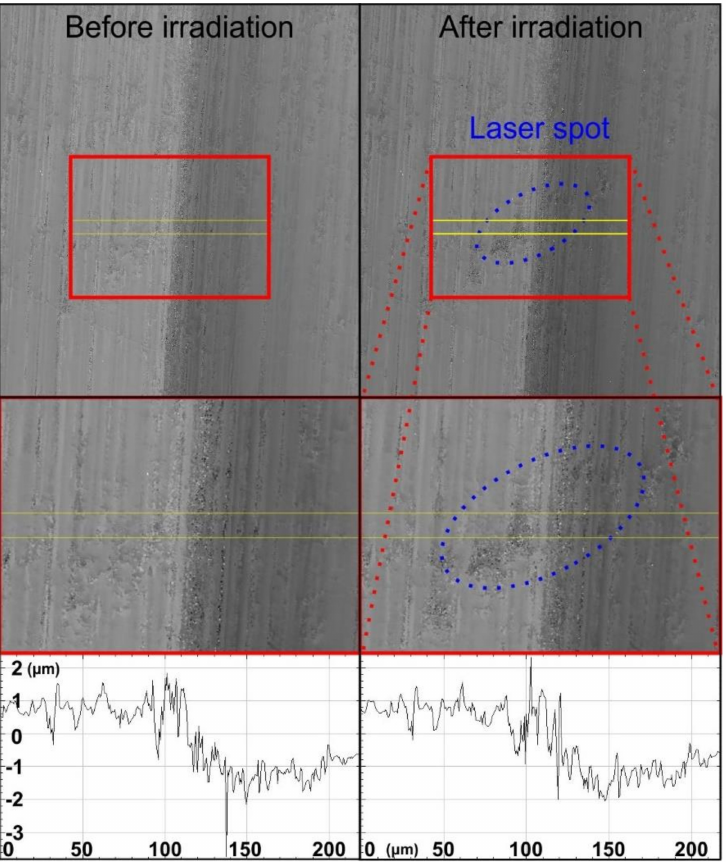
Figure 5. The 2D images of the area of interest, cropped images, and line-out graphs of the Al surface before and after irradiation. The images highlight the vicinity where the elliptical laser spot hits the surface of the